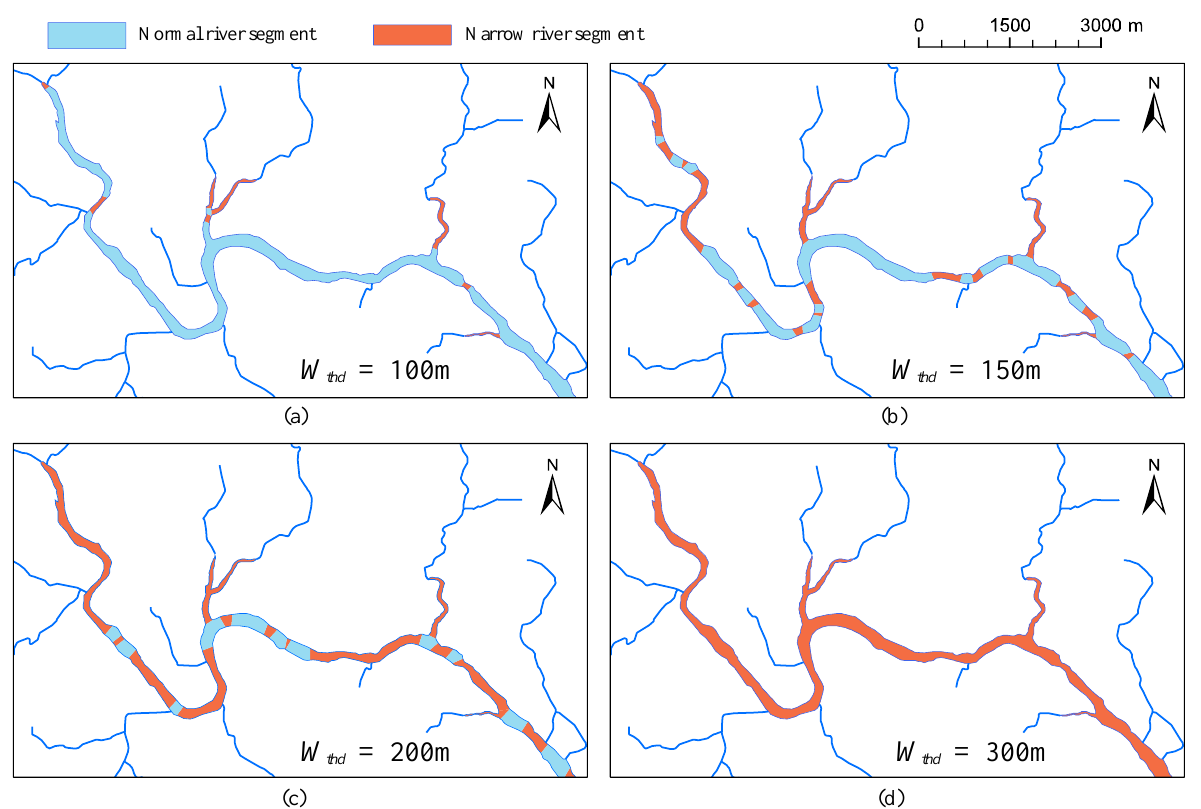
W ; ( b ) Figure 5. Progressive pre-segmentation results of the river segment: ( a ) W thd = 100 m; t hd